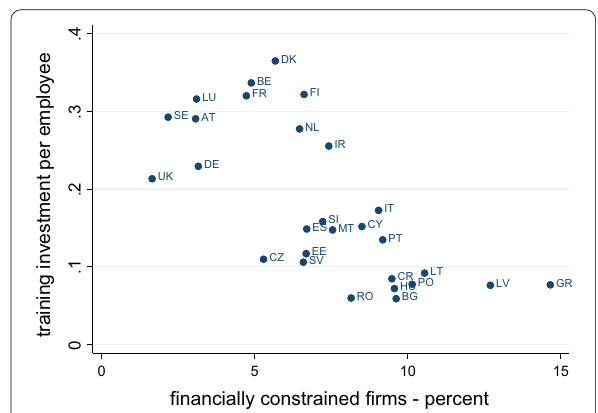
Fig. 1 Investment in training per employee (TI) and share of financially constrained firms (AC), by country. EIBIS 2015–18. Note: training investment is in thousand euro. Firms are weighted with value added weights provided by EIBIS to obtain values that are representative of the business population. Number of observations: 33,528. AT: Austria; BE: Belgium; BG: Bulgaria; CY: Cyprus; CR: